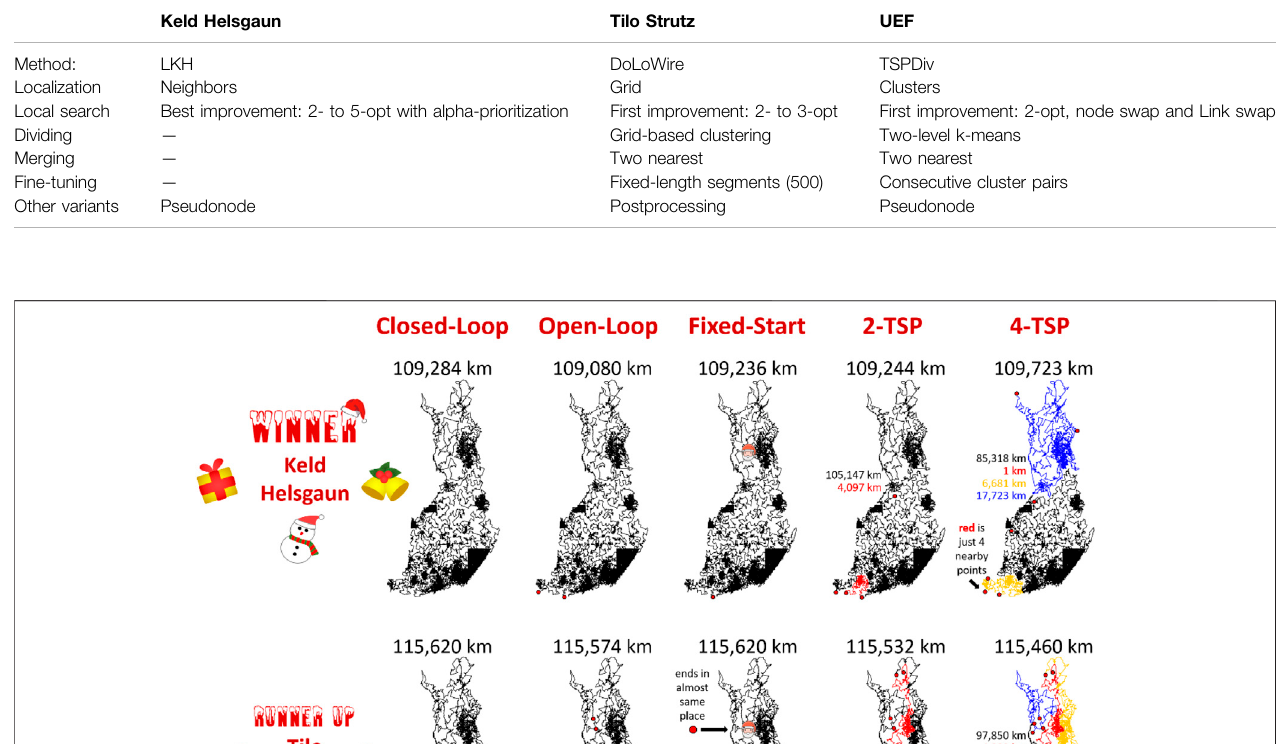
Figure 14 . The main observation is that the performance difference between the methods is clear. The tour length of LKH is 109,284 km, and it is clearly the shortest of all. The gap to the second best (DoLoWire) is approximately 6% and to the third best (UEF) is 12%. What is surprising is that LKH does not